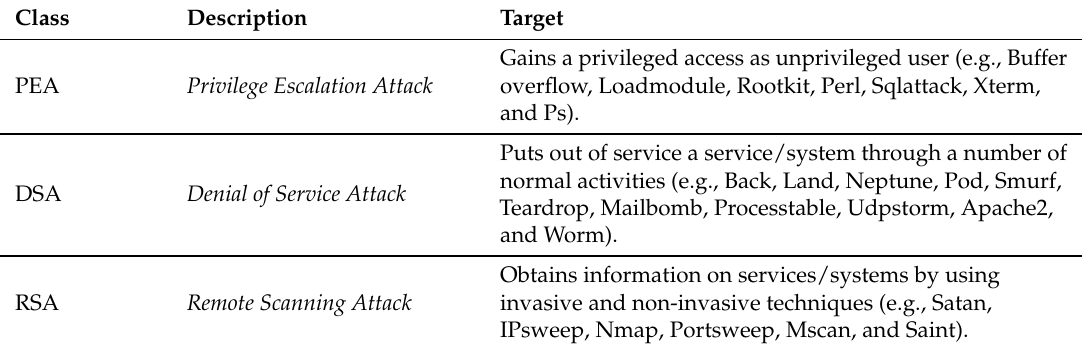
Table 8. Classes of dataset